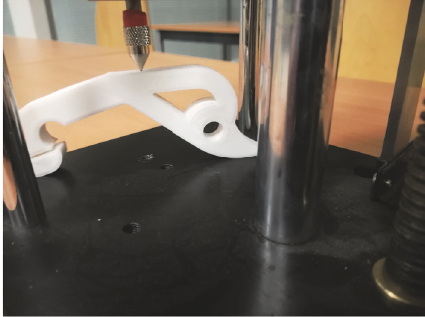
Figure 11: Error estimator 𝜂(𝑥, 𝑉 ∗ )/ max y ∈Ω the region of interest, where stresses are the